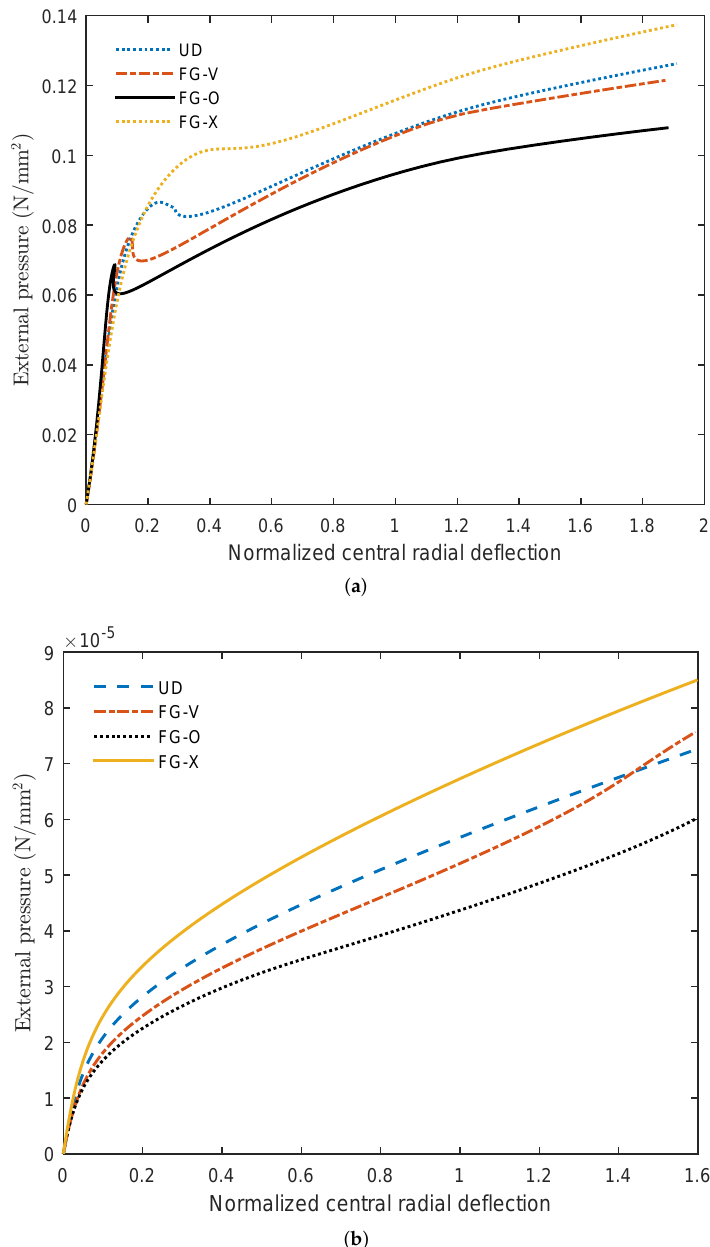
Figure 16. Normalized central radial deflections ˆ w of clamped FG-CNTRC cylinder shells/membranes = 0.11. ( a ) Cylinder shells, R / h = 80, ( b ) cylinder under external pressure with L / R = 4 and V ∗ CNT membranes, R / h =